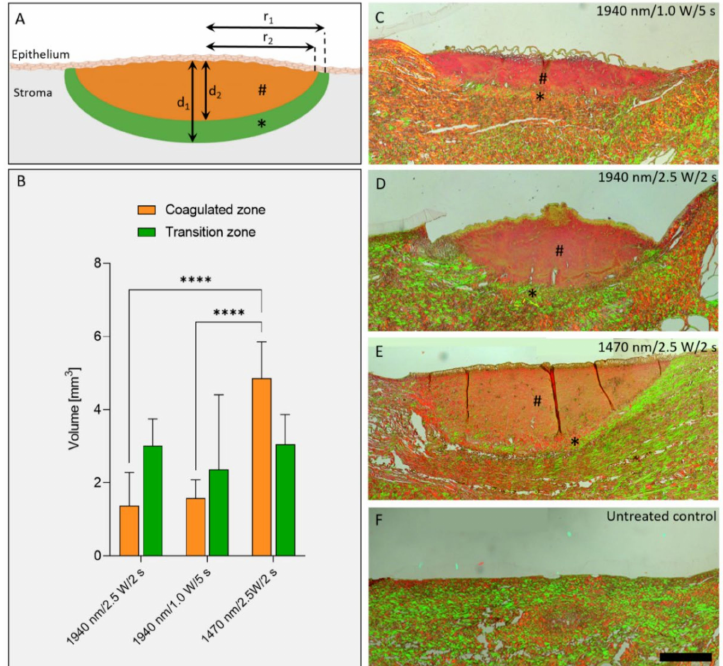
Figure 4. Evaluation of the thermally altered zones of laser damage of porcine eyelids. The coagulated zone (#) and the transition zone (*) was determined ( A ), and the volume of both zones was calculated ( B ) using the depth and the radius measured in Picro-Sirius-Red-stained cross-sections ( C – F ). In the transition zone, stronger birefringence was observed compared to the uncoagulated normal tissue. d 1 = depth coagulated zone plus transition zone; d 2 = depth coagulated zone; r 1 = radius coagulated zone plus transition zone; r 2 = radius coagulated zone. **** p < 0.0001. Scale bar: 500 µ